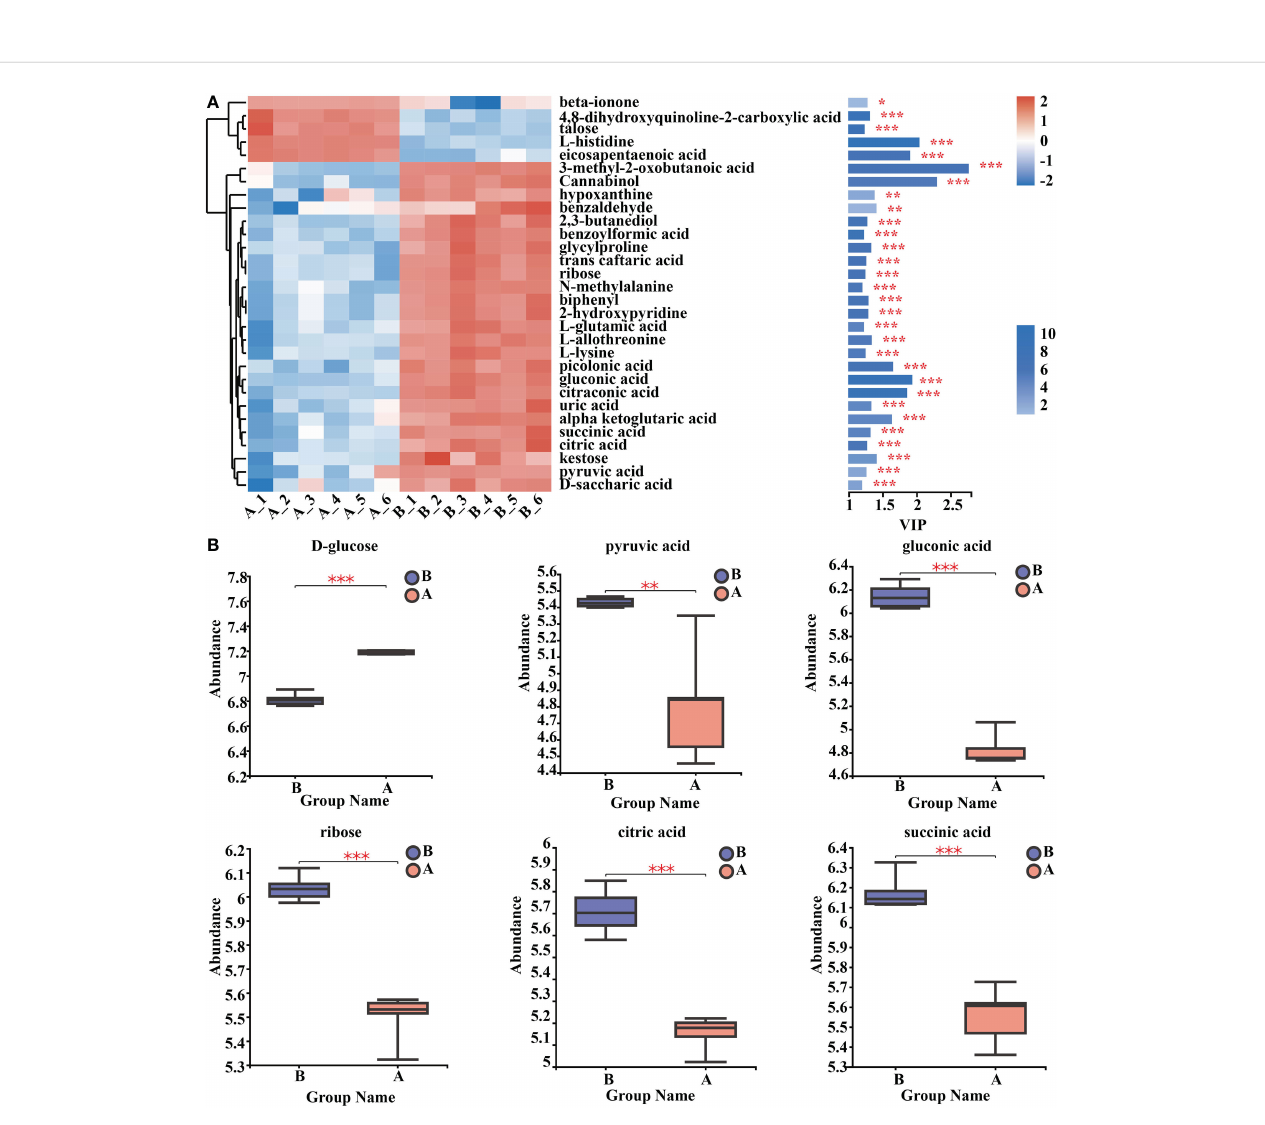
FIGURE 8 Analysis of key differential metabolites. (A) Metabolomics key differential metabolites enrichment. The smaller the p-value, the larger the -log 10 (p-value), and the darker the colour. (B) Relative expression abundance of key differential metabolites. The Y coordinate is the mass spectral intensity value (after data pre-processing). *, ** and *** indicates statistical signi fi cance at p< 0.05, p < 0.01 and p < 0.001, respectively (Student ’ s t-test).